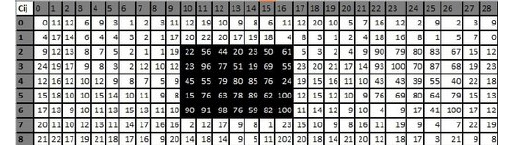
Figure 16: Zone with a strong degree of dirt.